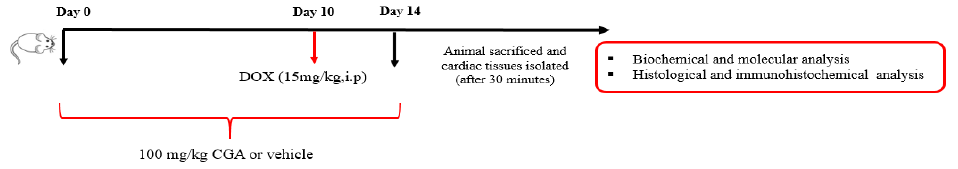
Figure 1. The fl owchart of the experiment design. Figure 1. The flowchart of the experiment